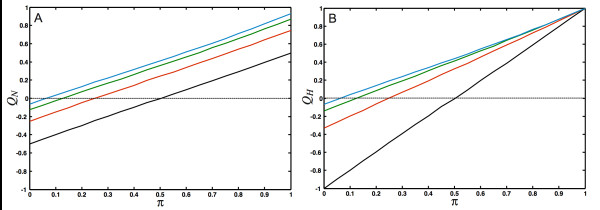
Comparison of modularity metrics. Comparison of the modularity measures defined in Eqs. (8) and (11). Networks with between 2 and 16 modules were grown depending on the intra-module edge probability π. (For π = 0 the networks are as anti-modular as possible and become k-partite (where k is the number of modules), while for π = 1 they are as modular as possible). (A): QN [defined in Eq. (8)] for Nc = 2 (2 modules, black line), Nc = 4 (red), Nc = 8 (green), Nc = 16 (blue). (B) QH [defined in Eq. (11)]. Colors as in (A). Each point was averaged over 50 networks with 1,000 nodes. The networks were grown with PN = 0.5, p = 1.0, PE = 1.0, q = 1.0 and PD = 0.0, using undirected edges.